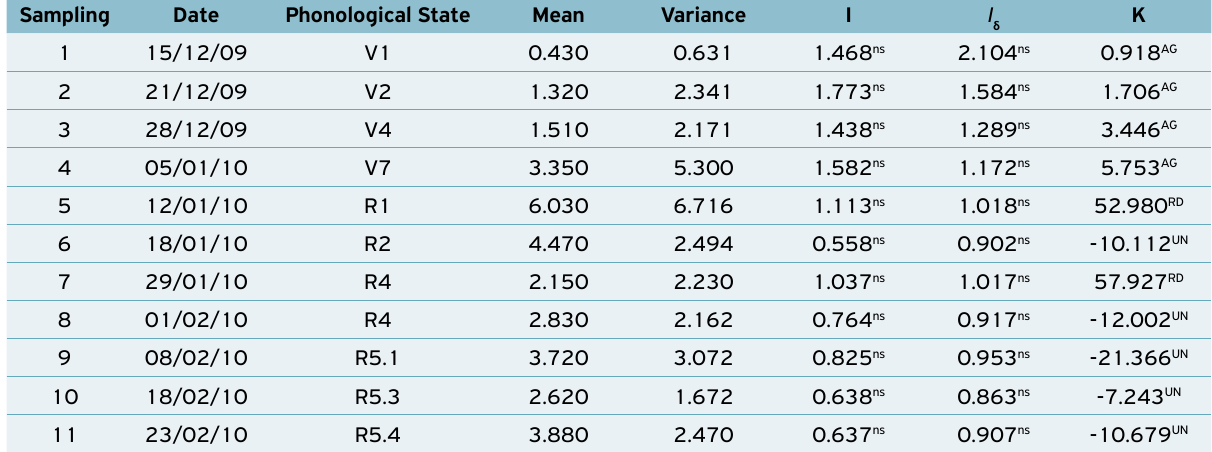
Table 1. Dispersion indices or aggregation, evaluation date, medium of infested plants, variance and spatial distribution indices used for infested plants by whitefly ( B. tabaci) during the 11 evaluations. I (variance/mean ratio), I Dourados, MS, 2010.